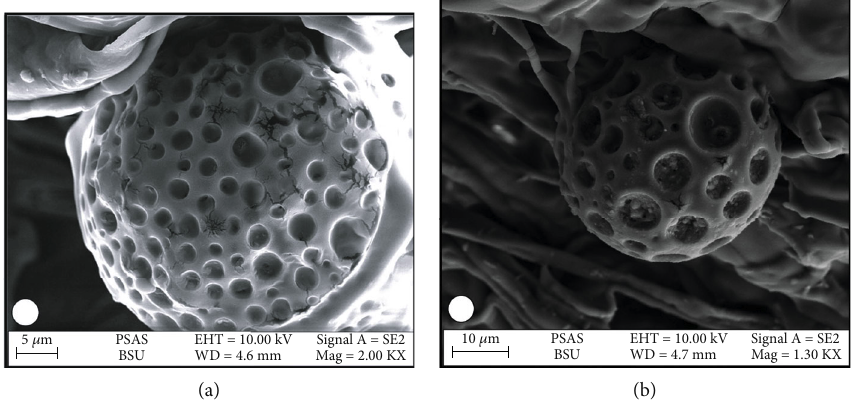
Figure 2: Scanning electron micrograph showing (a) PLGA and (b) CUR-loaded PLGA NPs.